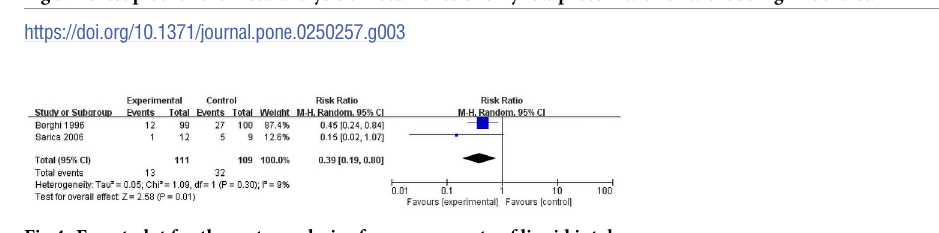
Fig 3. Forest plot for the meta-analysis of recurrence of only low protein with or without high fiberdiet.